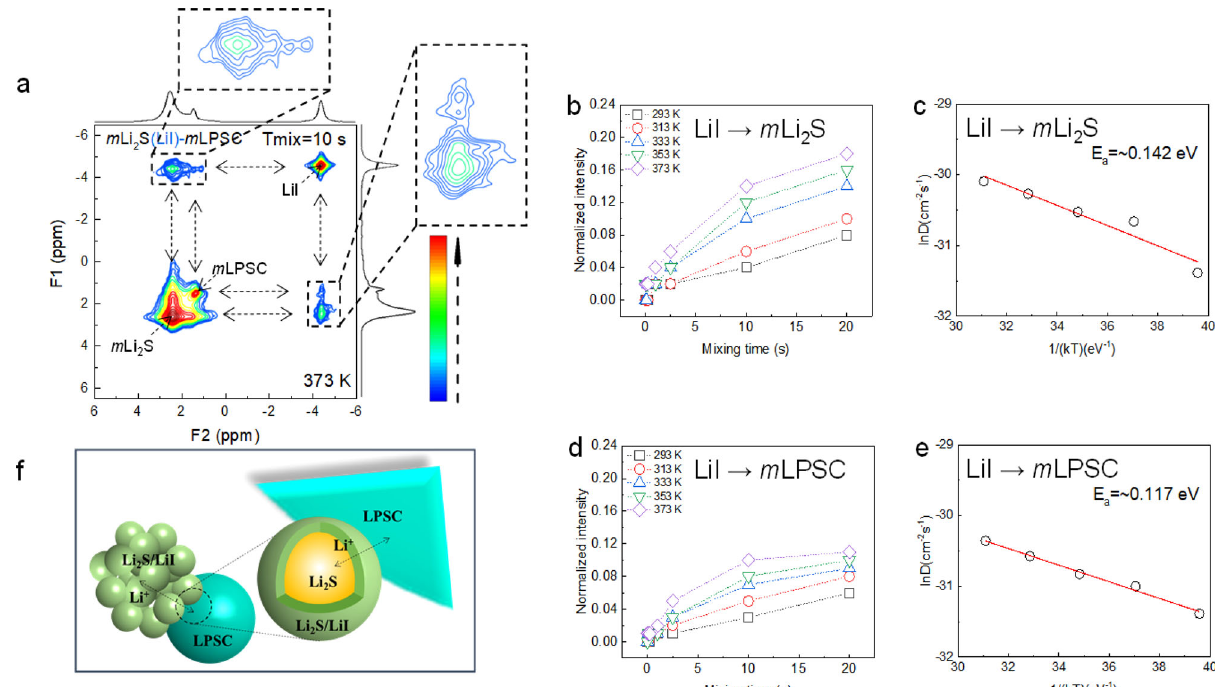
Fig. 4 Mechanism for Li + transport in the m Li 2 S(LiI)- m LPSC cathodic mixtures. a Two-dimensional 6 Li- 6 Li exchange spectra of the mixture of LPSC and Li 2 S-LiI powders measured at spinning speed of 10 kHz at 100 °C and a mixing time of 10 s. b, c Evolution of the cross-peak intensity as a function of T mix obtained from the temperature-dependent 2D-EXSY measurements. d , e Temperature dependence of the diffusion coef fi cient obtained from fi tting the data in ( b , d ). f Schematic of the proposed Li + transport mechanism in the mLi 2 S(LiI)-mLPSC-C cathodic